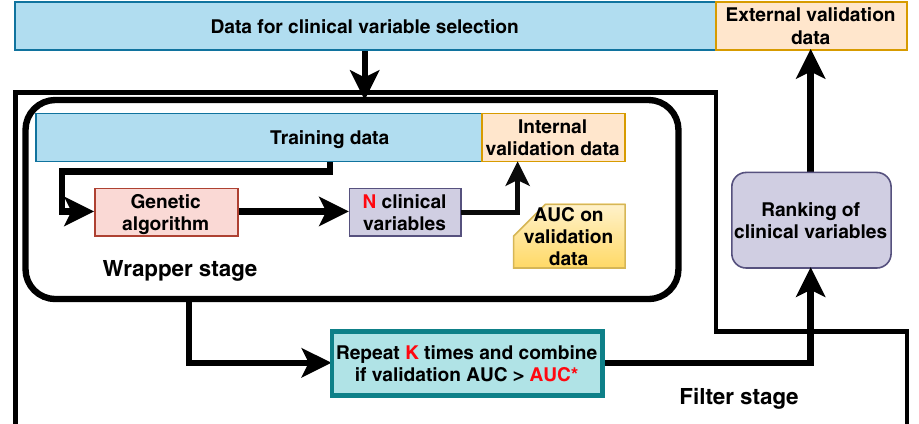
Figure 5. GA feature selection methodology. The result is a ranking of clinical variables, which is then validated on an independent set of